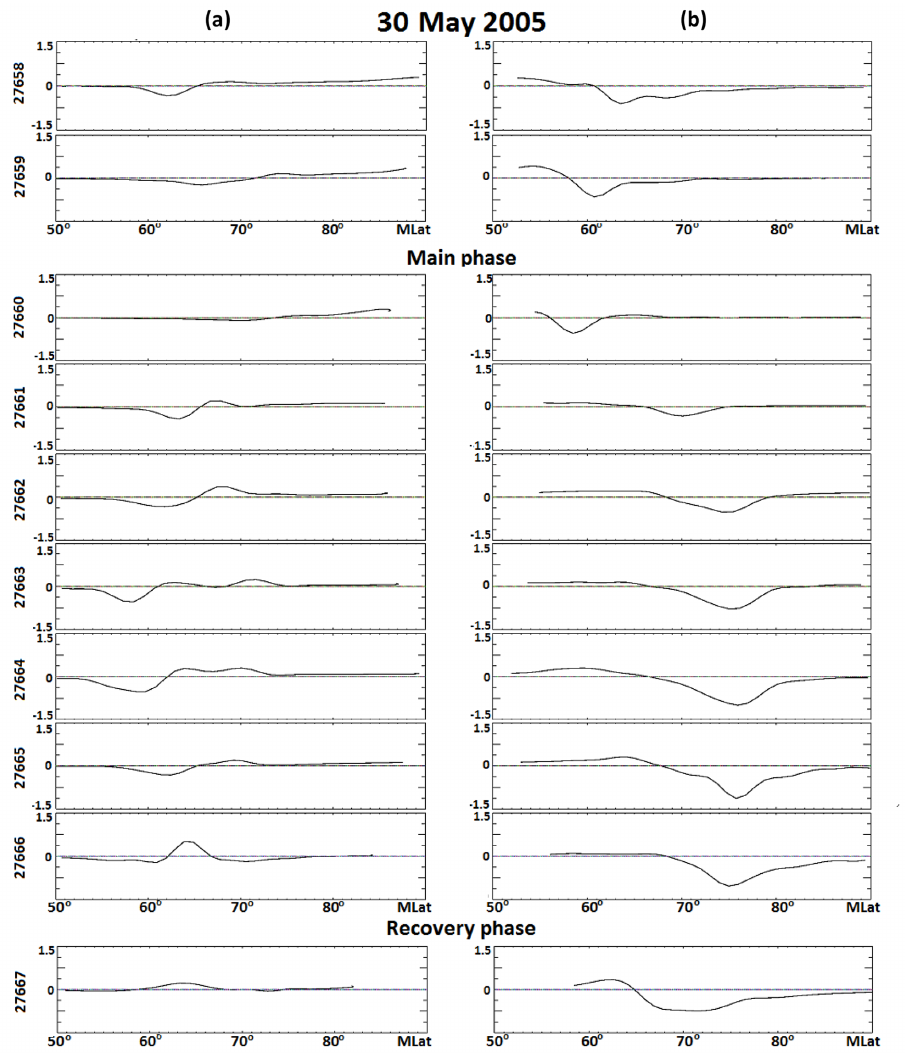
Figure A6. Direction and intensity values of the Hall current along the satellite orbit at the duskside ( a , 19:00–21:00MLT, corresponding to the ascending section of the orbit) and dawnside sectors ( b , 06:00–09:00MLT, descending orbit section). Positive currents denote an eastward current flow for the descending orbit section and a westward current for the ascending section,